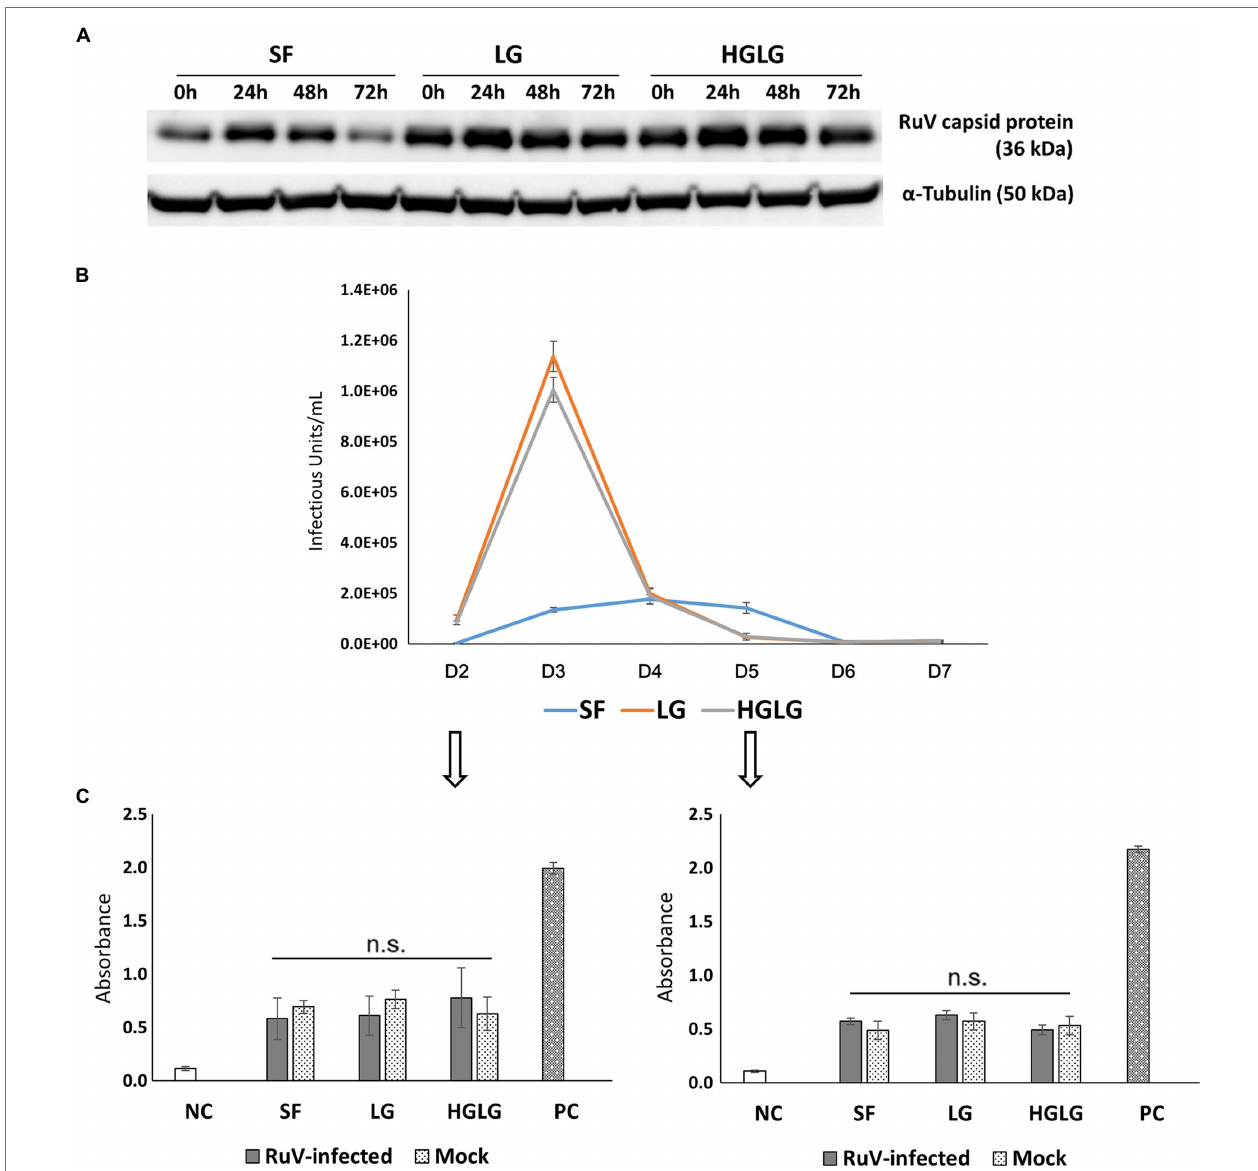
FIGURE 4 | Investigation of viral replication and apoptosis in LG-stressed RuV-infected HTR-8/SVneo cells. (A) Viral replication in LG-stressed RuV-infected cells shown by Western blotting. Trophoblast cells were cultured in 12-well plates, subjected to LG stress, and then inoculated with RuV. At 0, 24, 48, and 72 hpi, the lysate was collected for Western blot analyses. Cells cultured in SF medium were used as the controls for LG stress treatments. (B) Titers of viral progeny in the supernatants collected from day 2 to day 7 pi as determined by FCM analysis. Trophoblast cells were cultured in a 96-well plate and subjected to LG stress and RuV infection as described. From 48 hpi, the entire supernatant was collected daily and replaced with a new medium until day 7 pi. The collected supernatants were used to infect freshly prepared Vero cells and titered by FCM analysis as described elsewhere. The graph is representative of two independent experiments. The results are expressed as the mean of at least triplicate experiments in each group, and the graph is representative of two independent experiments. (C) No enhancement of apoptosis of LG stress-infected trophoblast cells. Trophoblast cells were seeded at a density of 5 × 10 3 cells/well onto a 96-well flat-bottom plate as specified by the manufacturer. After 2 d of culture and subsequent LG stress and RuV infection, ELISA detection of single-stranded DNA present in apoptotic cells was performed at days 2 and 5 pi. The cells subjected to LG stress and mock infection were treated in parallel and used for comparison. Single-stranded DNA provided in the ELISA kit was used as a positive control. The results are expressed as the mean of at least triplicate experiments in each group, and the graph is representative of two independent experiments. NC, negative control; mock, mock-infected with virus-free medium; PC, positive control; n.s.,